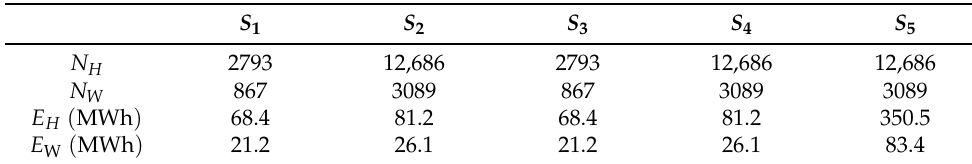
Table 2. Maximum number of charging events and respective energy demand per day during the simulation time span. Results are segregated by home and workplace charging for each scenario under